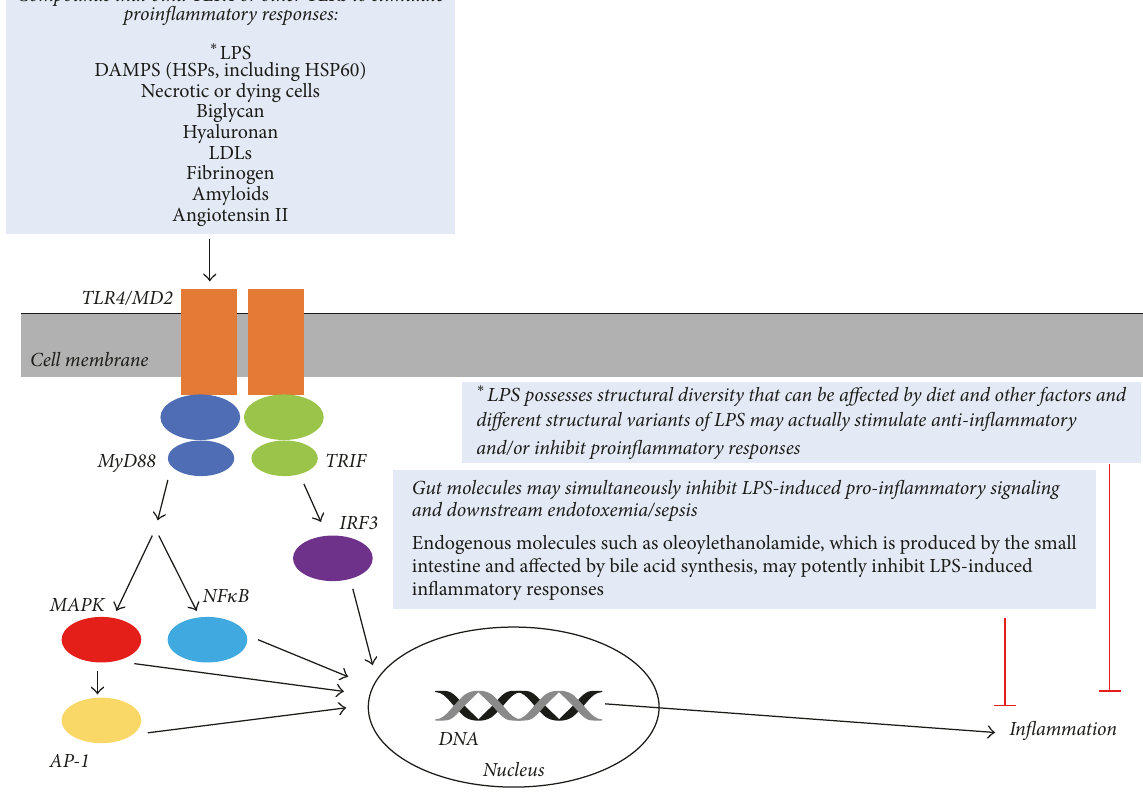
Figure 4: Many compounds other than lipopolysaccharide (LPS) can bind to a proinflammatory receptor on immune cells, TLR-4 (toll-like receptor-4). When TLR-4 and its accessory proteins, including lymphocyte antigen 96 (MD-2), are triggered by some of these compounds, two main pathways through initial signaling proteins MyD88 (myeloid differentiation primary response gene 88) and TRIF (TIR domain containing adaptor-inducing interferon-beta) stimulate a cascade of signaling to multiple proteins. The end result involves proteins that enter the nucleus, bind to DNA, and change gene expression to stimulate the production of proinflammatory proteins. Structural variations in LPS molecules can affect how robustly this response occurs, by affecting the strength of binding at TLR-4 to stimulate the initial signal. Additionally, other molecules or proteins may independently affect the strength of the proinflammatory response to LPS. MAPK (mitogen associated protein kinase); NF 𝜅 B (nuclear factor kappa light chain enhancer of activated B-cells); IRF3 (interferon regulatory factor 3); AP-1 (activator protein